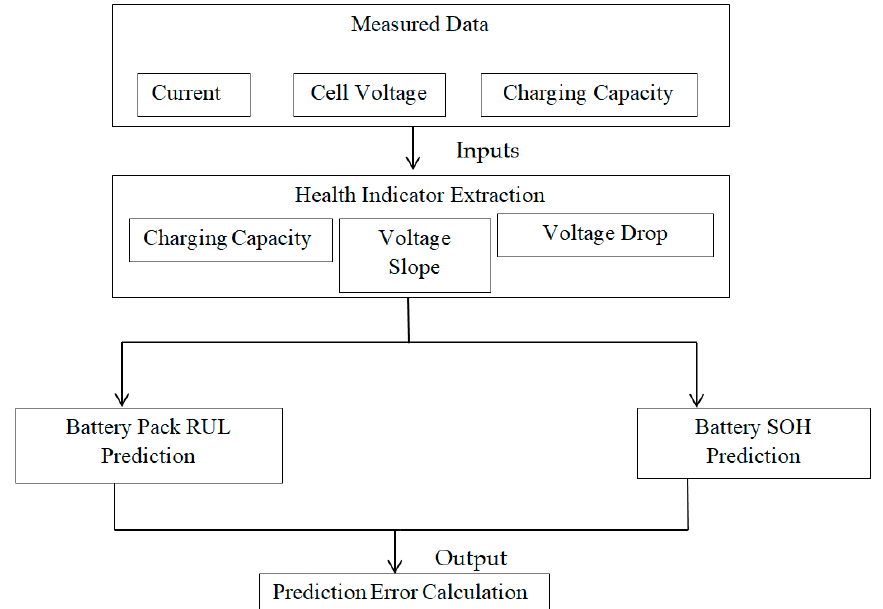
Figure 16. Flow chart of Dual GPR based SOH model .